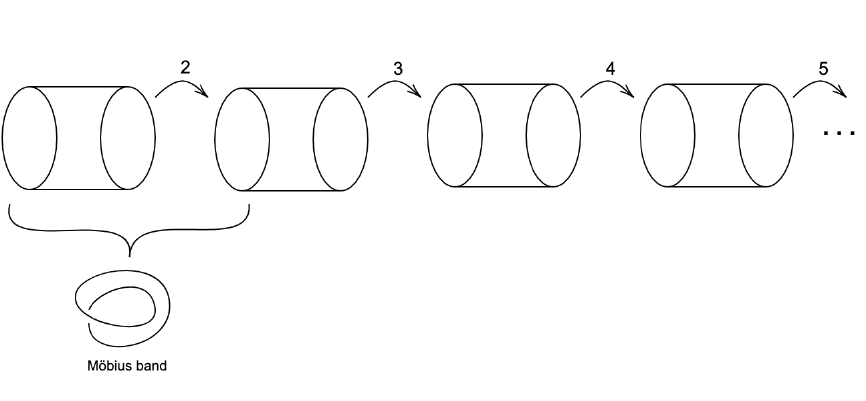
Figure 2.1: A rational circle [8, Lemma 7.5]. Note how the circle representing the left end of the leftmost cylinder may be arbi- trarily divided in the fundamental group, by pushing it to the right an appropriate number of times (and multiplying if neces- sary). For example, to divide by three we may push it two cylinders across (seeing how to divide by six) and multiply by two. Hence the fundamental group of this construction is Q . For higher dimensional spheres mapping in, note that by compactness any map will land in a finite stage of the construction, which deformation retracts onto a circle, and is hence nullhomotopic. Hence π ≥2 = 0